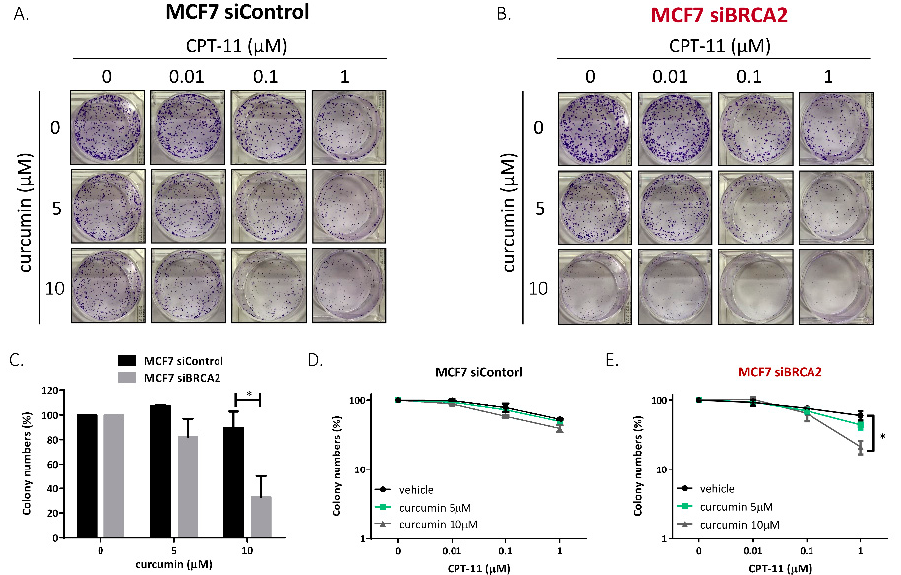
Figure 3. Curcumin specifically sensitized BRCA2-deficient cells to CPT. ( A , B ) Clonogenic assay. Transfected cells were grown for 10–14 days before fixation and staining with crystal violet. The detailed procedures are described in the Mate- rials and Methods section. ( C ) MCF7-siBRCA2 cells were more sensitive to curcumin treatment than MCF7-siControl cells. Quantification of colony numbers from the first columns of Figure 3A and Figure 3B. ( D , E ) Curcumin sensitized BRCA2- deficient cells to CPT-11 treatment. Quantification of colony numbers from A and B. Asterisks (*) indicate significant dif- ferences between CPT-11 and combined CPT-11 and curcumin cells (* p <